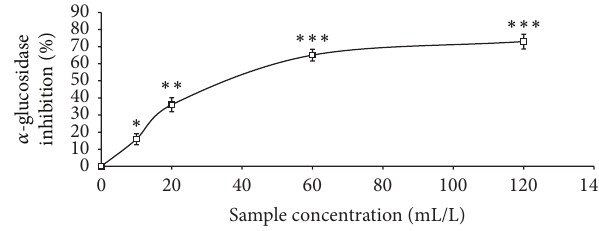
Figure 5: 𝛼 -Glucosidase inhibitory activity of essential oils from black pepper. Values represent means ± standard deviation of triplicate readings.